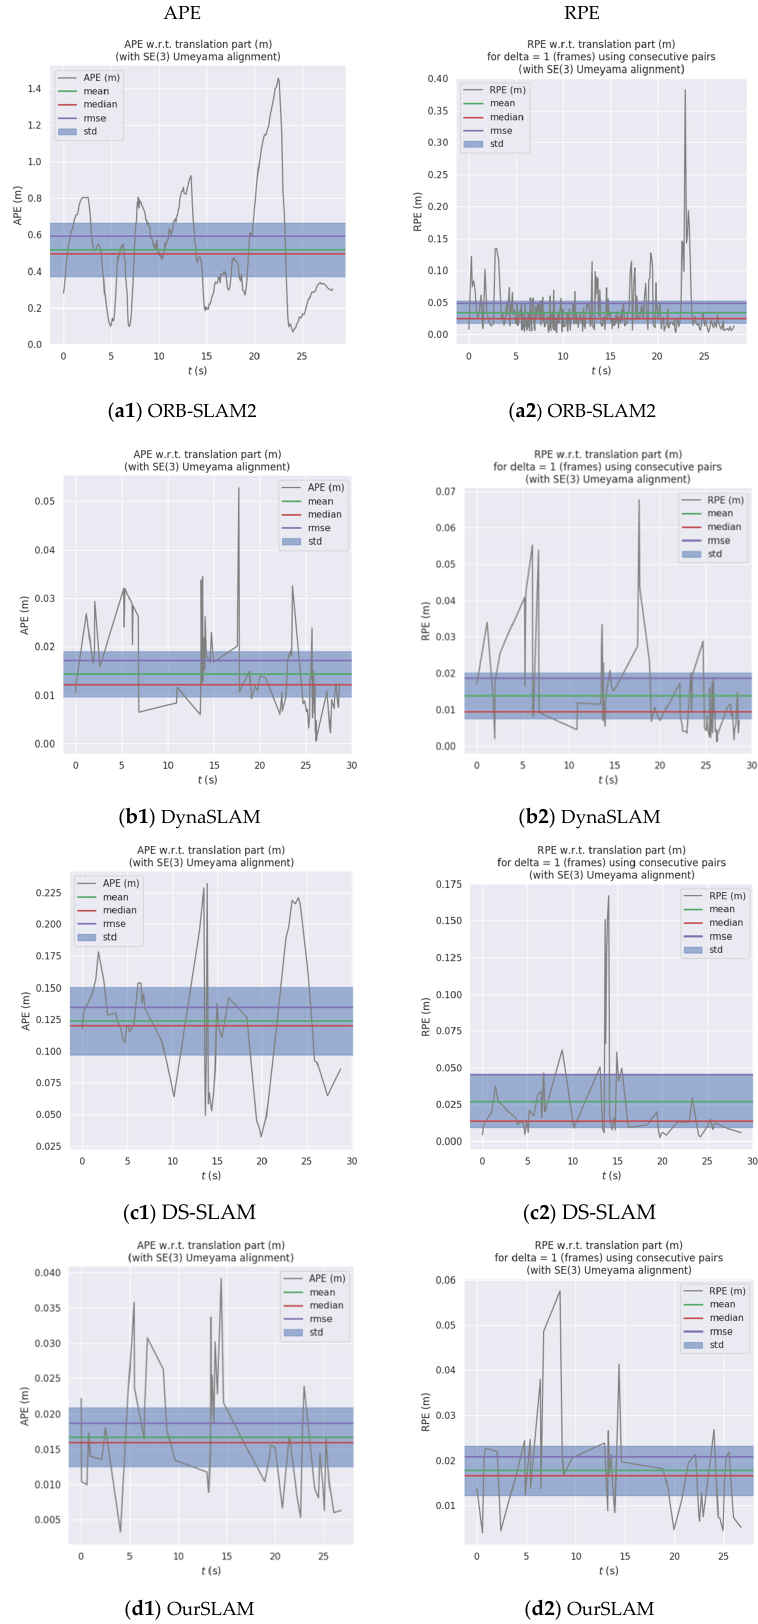
Figure 8. APE, RPE results for ORB-SLAM2, DynaSLAM, DS-SLAM, and OurSLAM on dataset fre3_walking_xyz.